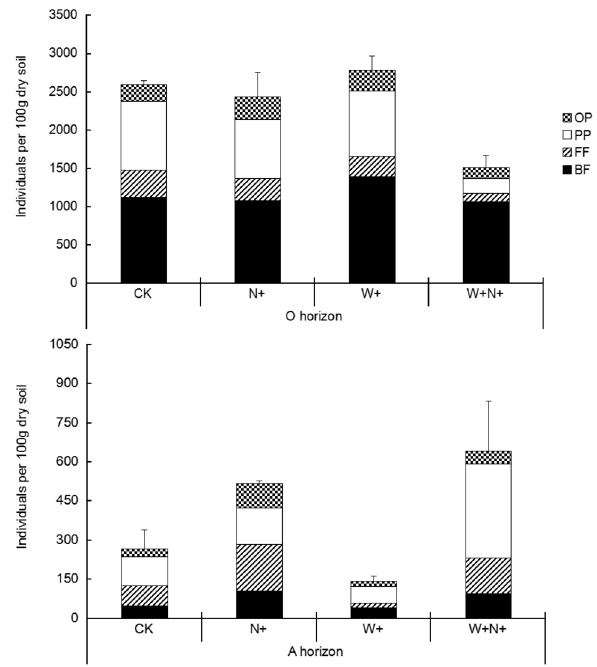
Figure 2. The abundances of total nematodes and trophic groups among different water or/and N addition predators; PP, plant-parasites;